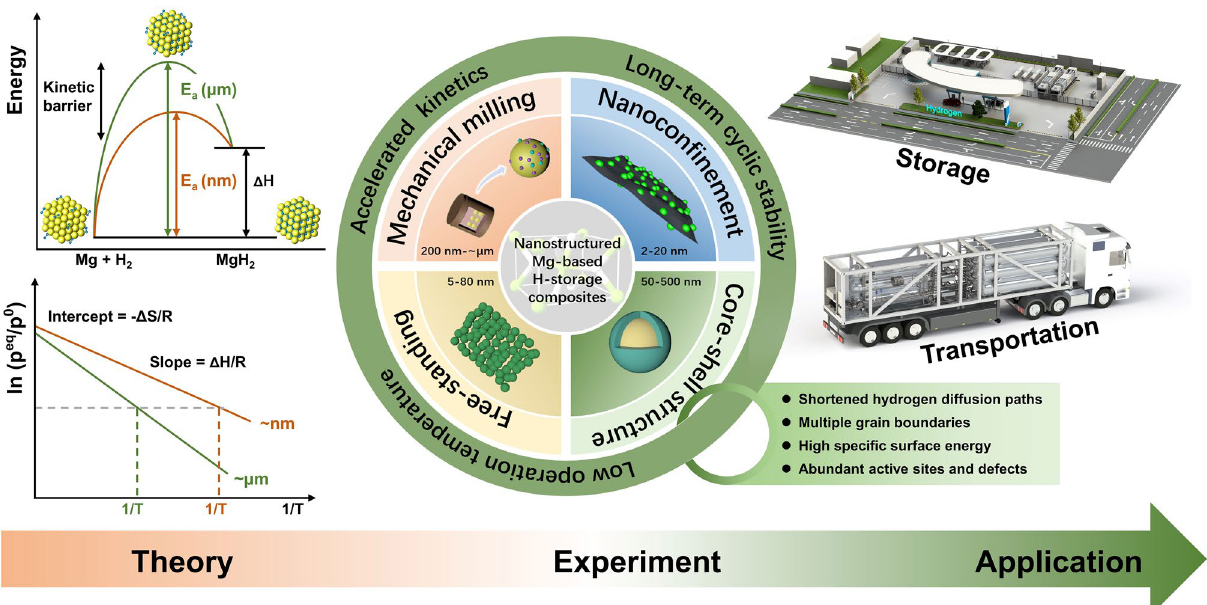
+ H ⇄ MgH 2 2 transition. b van’t Hoff plot related to the phase transition of